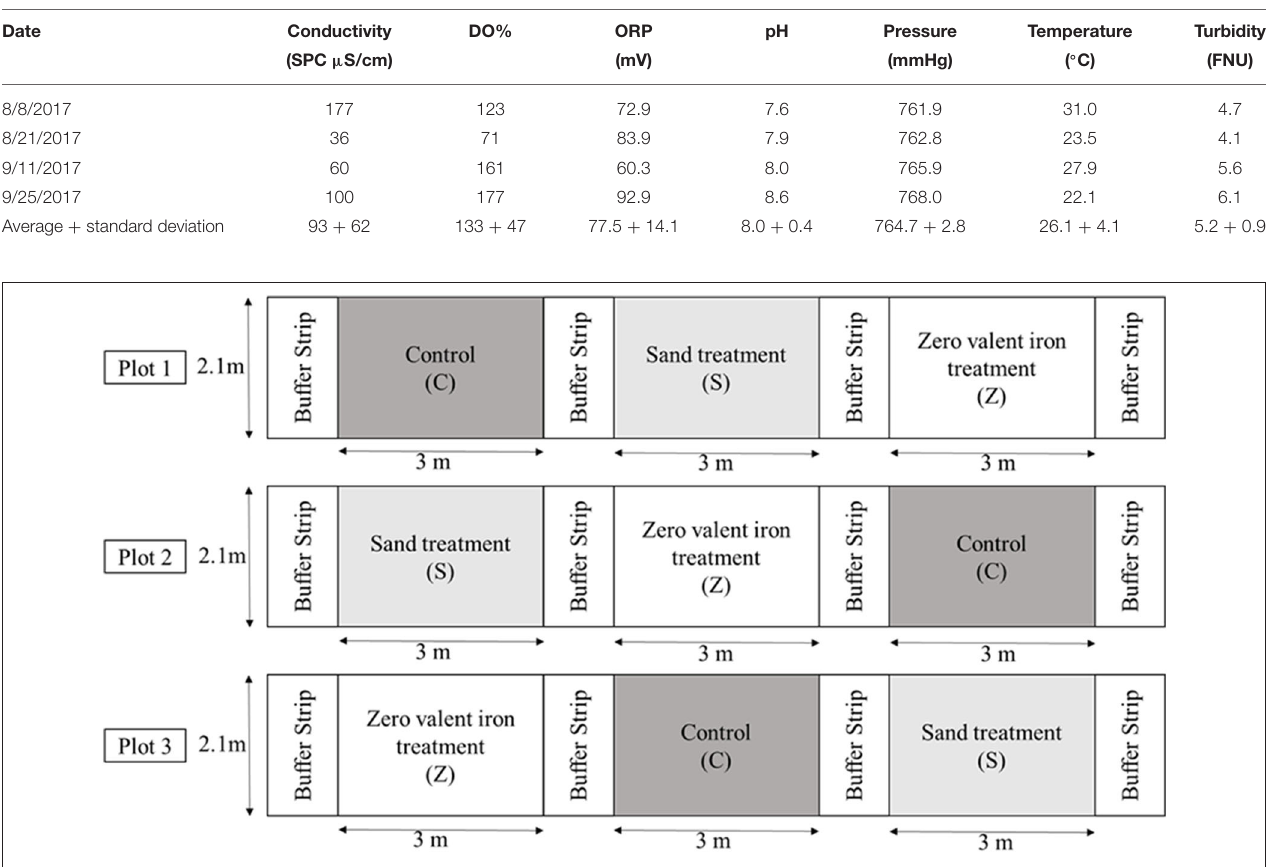
FIGURE 2 | Field design of Savoy spinach plots irrigated with either Zero-valent iron sand-filtered water, sand-filtered water, and control (not filtered water) containing E. coli